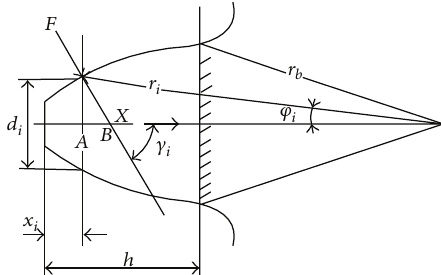
Figure 3: The schematic diagram of a cantilever